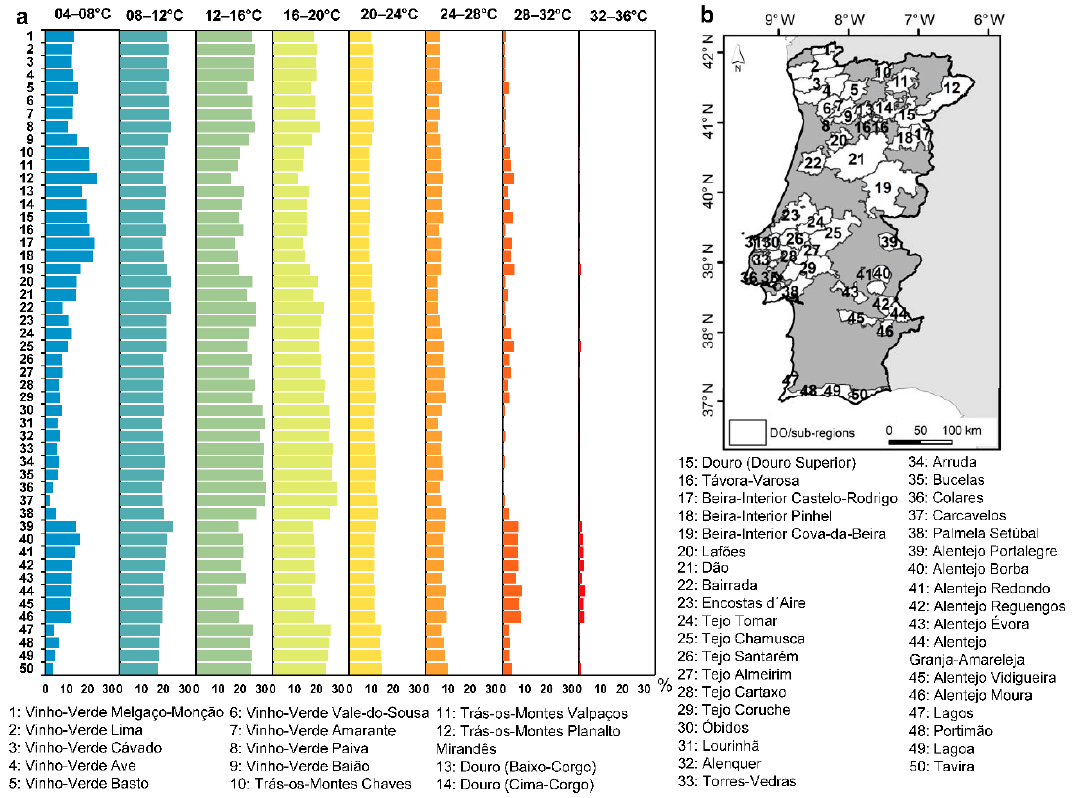
Figure 8. ( a ) Relative bar chart (in %) for the number of hours by different temperature intervals and for each DO/sub-region of wine. ( b ) Geographical location of the protected denominations of origin (DOs) and sub-regions (see the list for their designations). Area-means are computed only over the land with vineyard areas (source: COS2007).